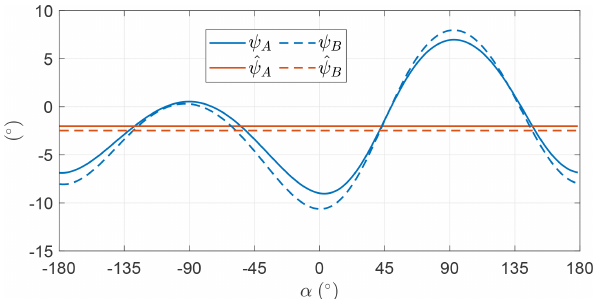
Figure 25. Optimal ψ as a function of the angular position.